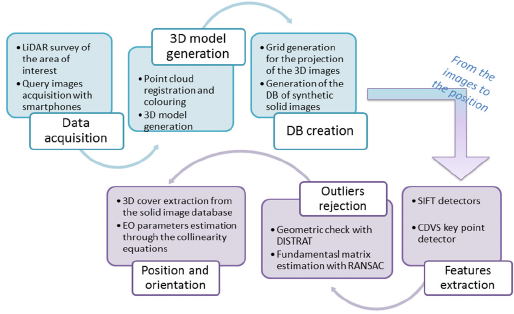
Figure 1. Workflow of the image recognition based location (RBL) procedure.